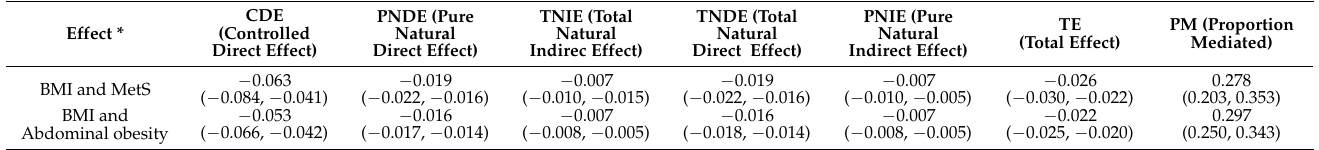
Table 3. Mediation analysis of